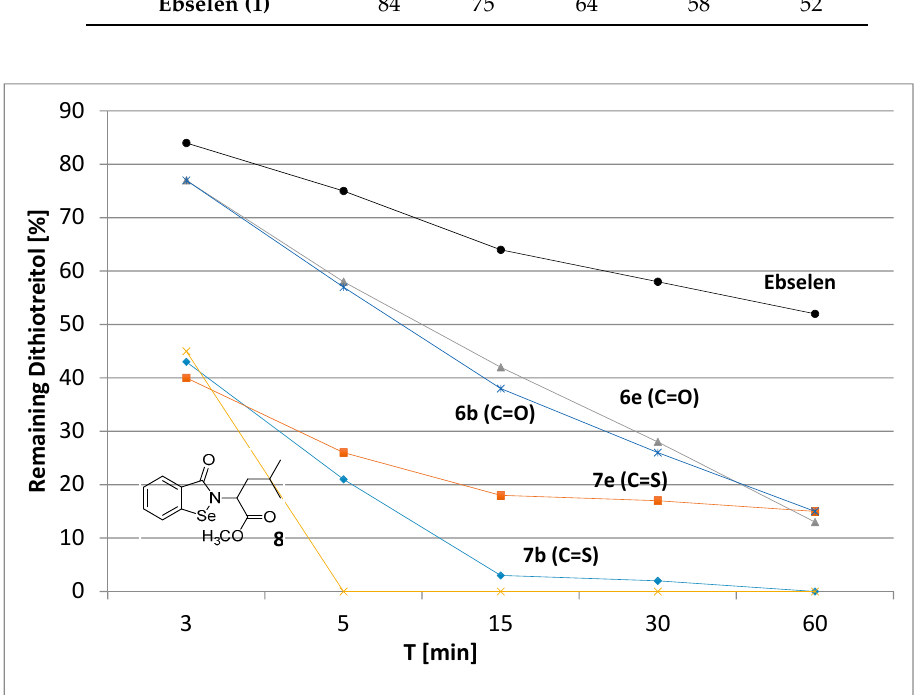
Figure 1. Graphical comparison of antioxidant activities.